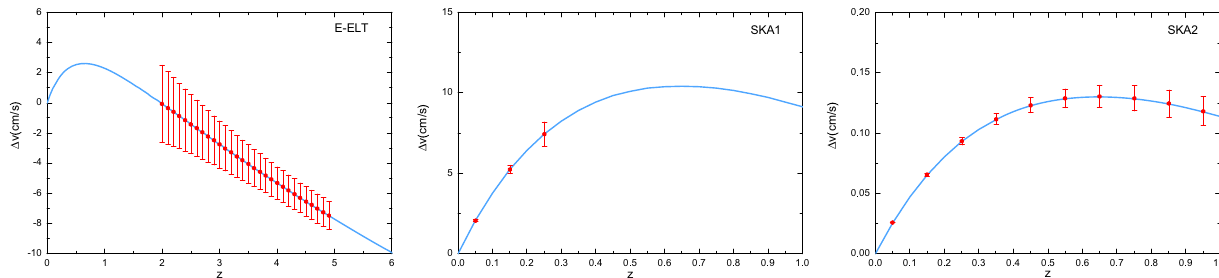
Fig. 1 Curve of (cid:7)v versus z in the (cid:2) CDM model. Parameter values are fixed as the best-fit values to SN+CMB+BAO. The error bars on the curves are estimated from E-ELT (left), SKA1 (middle) and SKA2 (right)